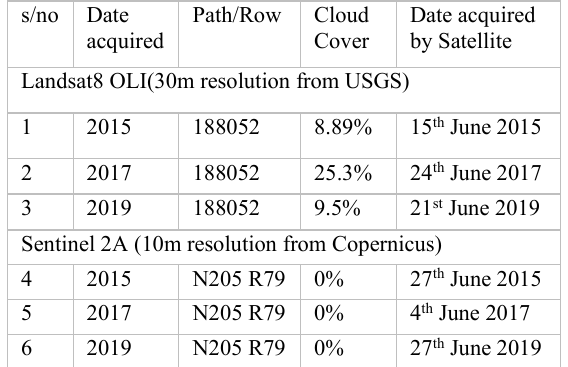
Table1: Details of Landsat8 OLI and Sentinel 2A Image